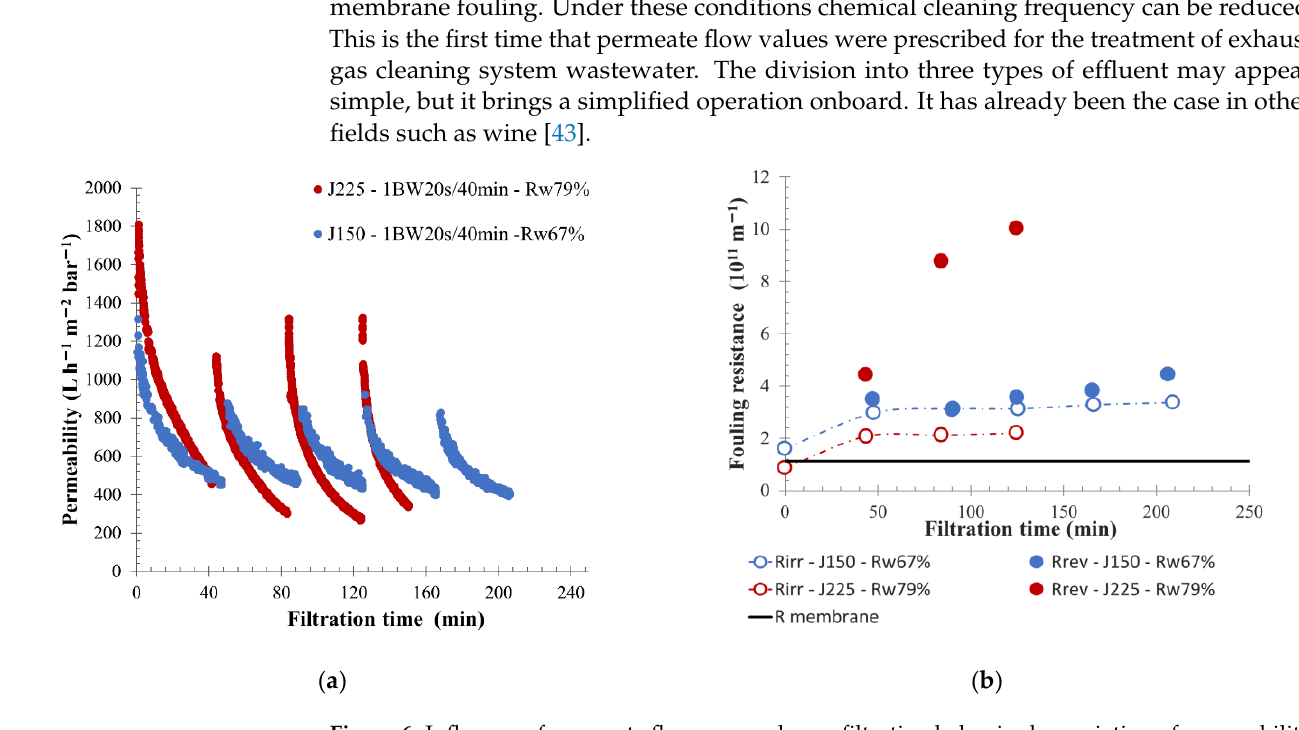
Figure 6. Influence of permeate flux on membrane filtration behavior by variation of permeability at 20 °C ( a ) and fouling resistance ( b ) throughout the time with backwash water injected for 20 s every 40 min. Flux of 225 L h −1 m −2 (round), 150 L h −1 m −2 (triangle) is applied to the membrane. T = 20 °C, feedwater from APL-SINGAPURA-ME; SiC membrane 0.33 m 2 . Jxx is permeate flux at the xx value in L h −1 m −2 ; 1BW yy s/zz min where yy is the duration and zz the interval of filtration between two BF; and R w is the total recovery rate applied on the unit; R irr is irreversible resistance; R rev is reversible resistance and R membrane is the membrane resistance.